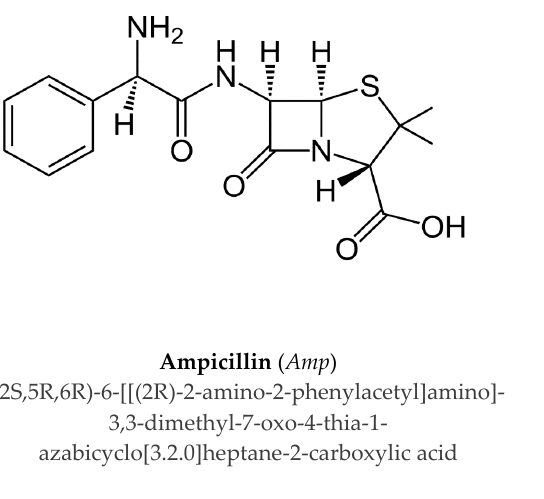
Figure 1. Ligands under study.